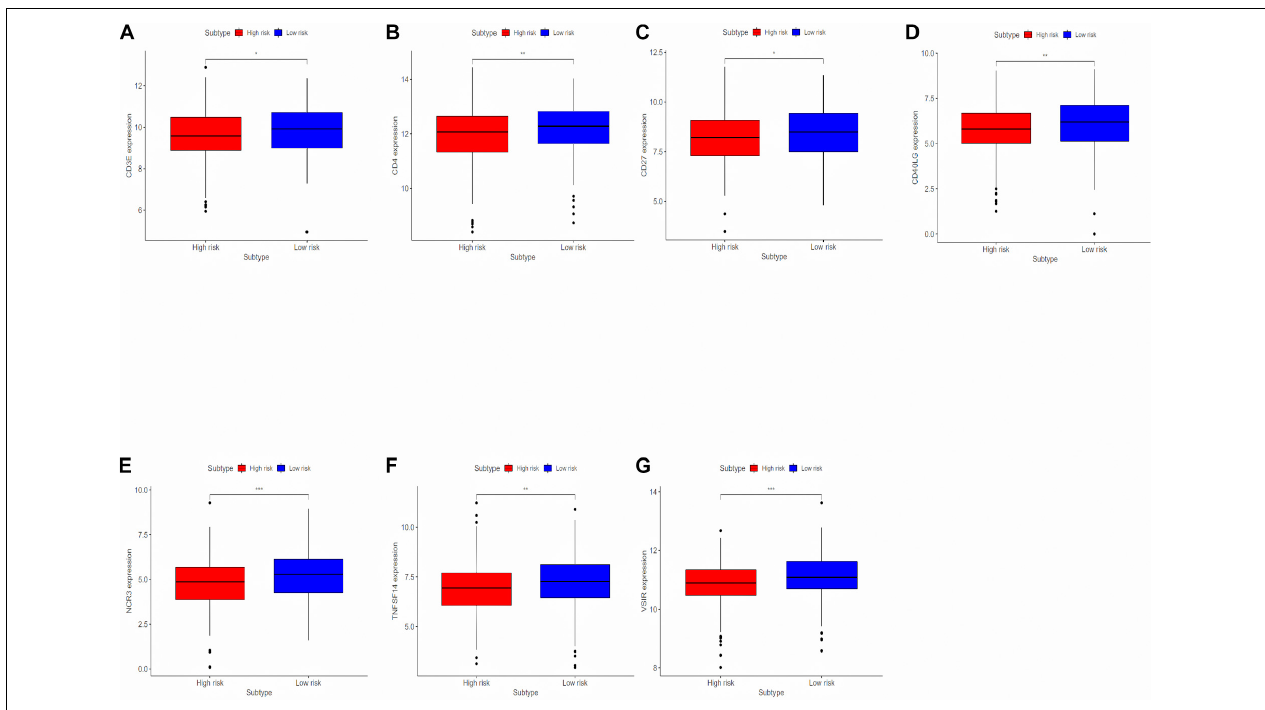
FIGURE 6 | Analyzing differentially expressed genes related to the immune response between the high-risk group and the low-risk group. (A–G) Differentially expressed genes related to the immune response between the high-risk group and the low-risk group. * P < 0.05, ** P < 0.01, and *** P <